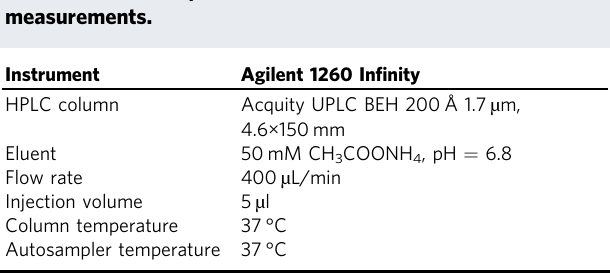
Fig. 10 NMR Numbering scheme of the platinum ligands. The letters stand for B - BSO; M - maleimide and D - Table 1 SEC-HPLC parameters for SEC-ICP-MS